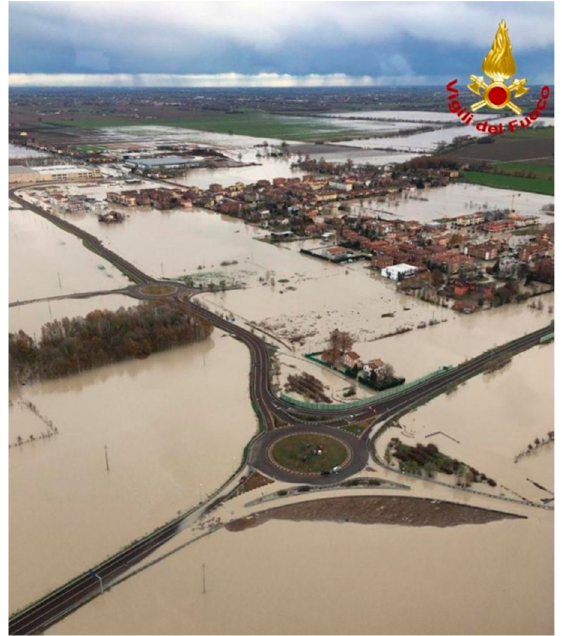
Figure 3. Picture of the flooded area of Nonantola (courtesy of the Italian National Fire Corps).